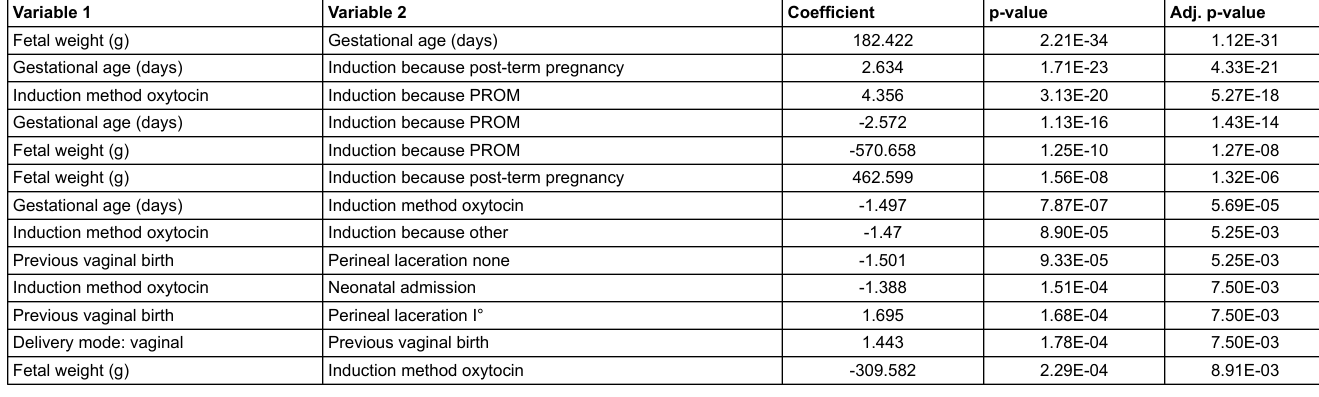
Table 2: Significant one-to-one correlations in the investigated cohorts (induction method catheter and oxytocin after caesarean section).